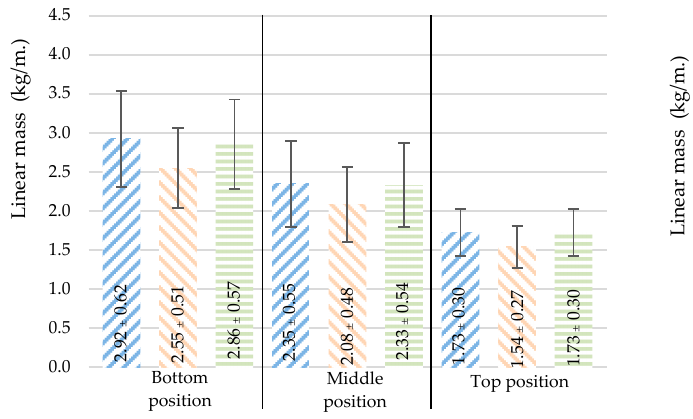
Figure 7. The density varied with moisture content and position: ( a ) internode, ( b ) node (mean ± standard deviation).